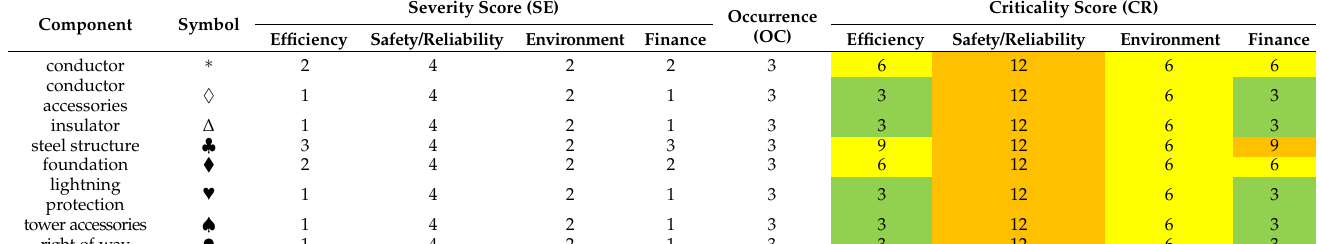
Table 11. Severity and criticality analysis of the 230 kV transmission line tower no. 1, line no. 8. Component